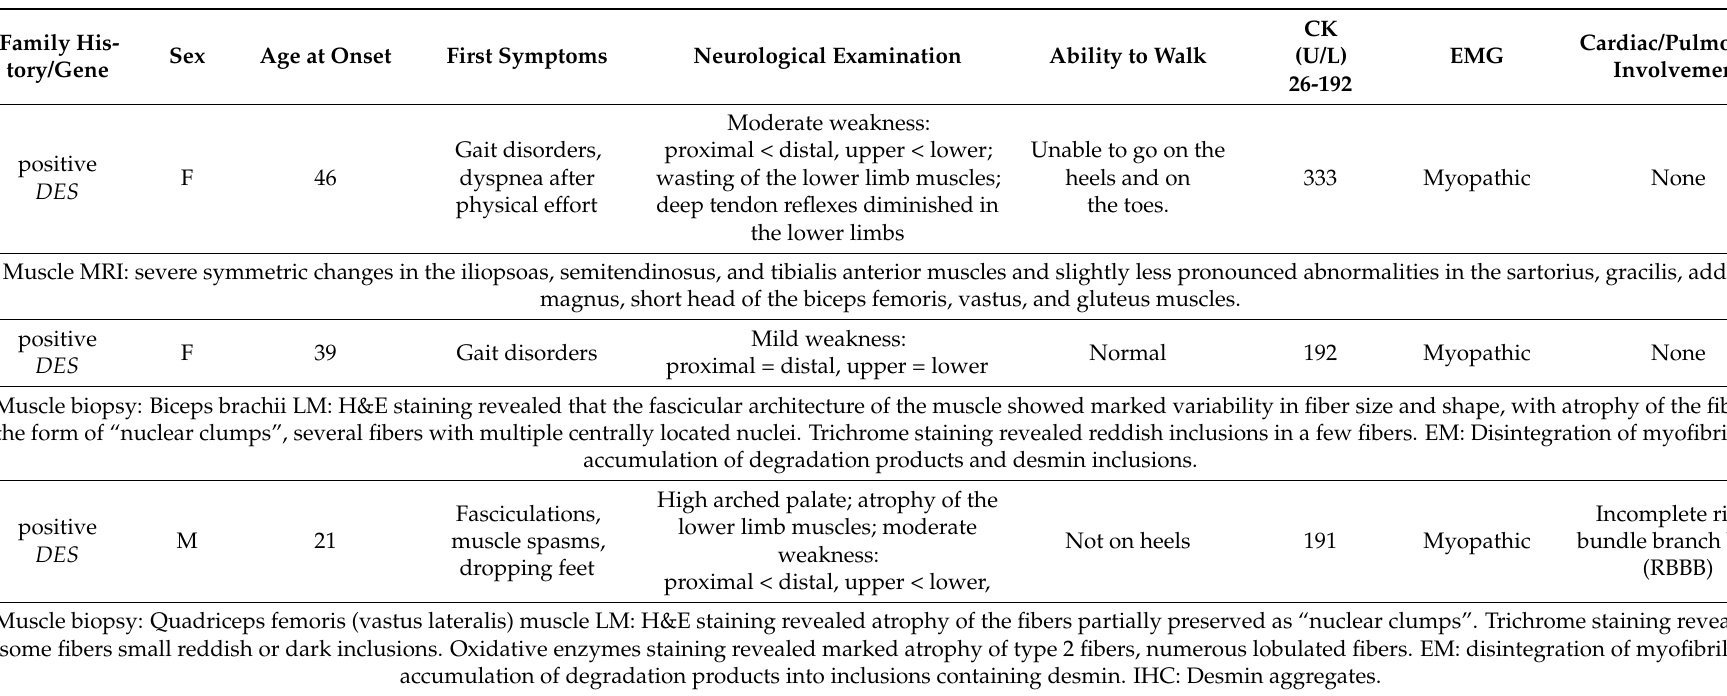
Table 3. Clinical features of the